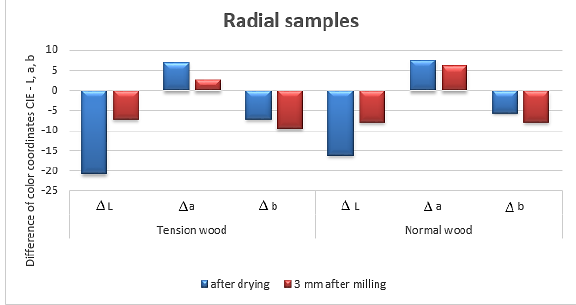
Figure 4: Difference of color coordinates L , a , b of the radial test samples